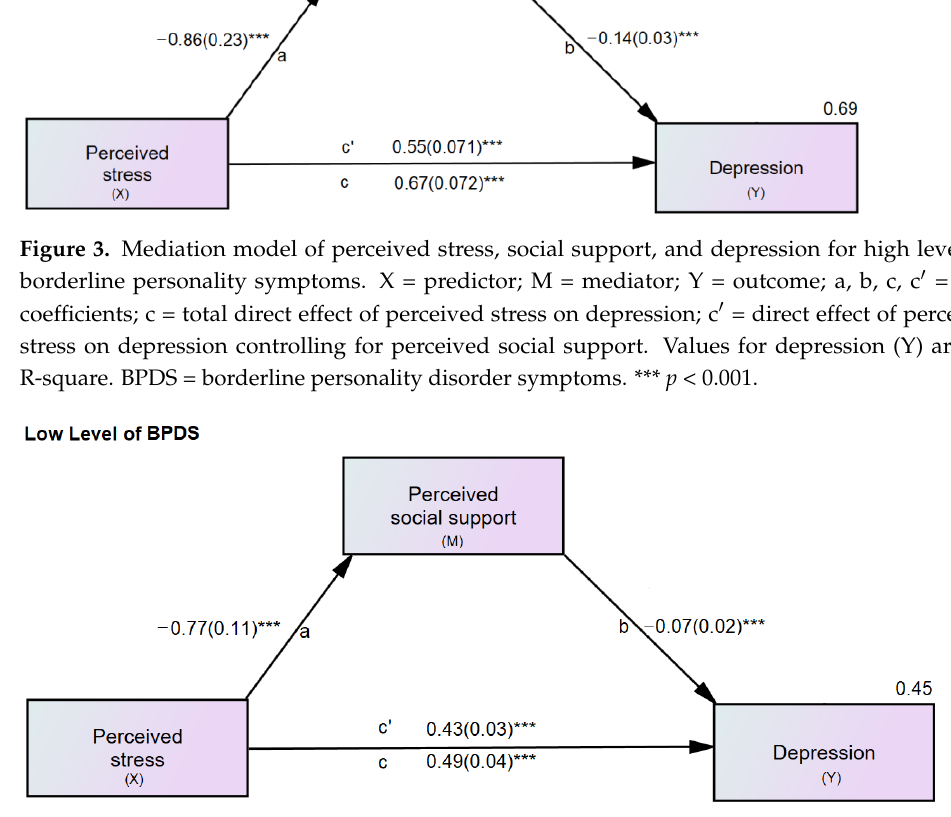
The correlation coefficients among low levels of BPDS (n = 265) are in the upper quadrant; the cor- relation coefficients among high levels of BPDS are in the lower quadrant (n = 65). PSS = Perceived Stress Scale, MSPSS = Multidimensional Scale of Perceived Social Support, PHQ = Patient Health Questionnaire, BPDS = borderline personality disorder symptoms. ** p < 0.01.